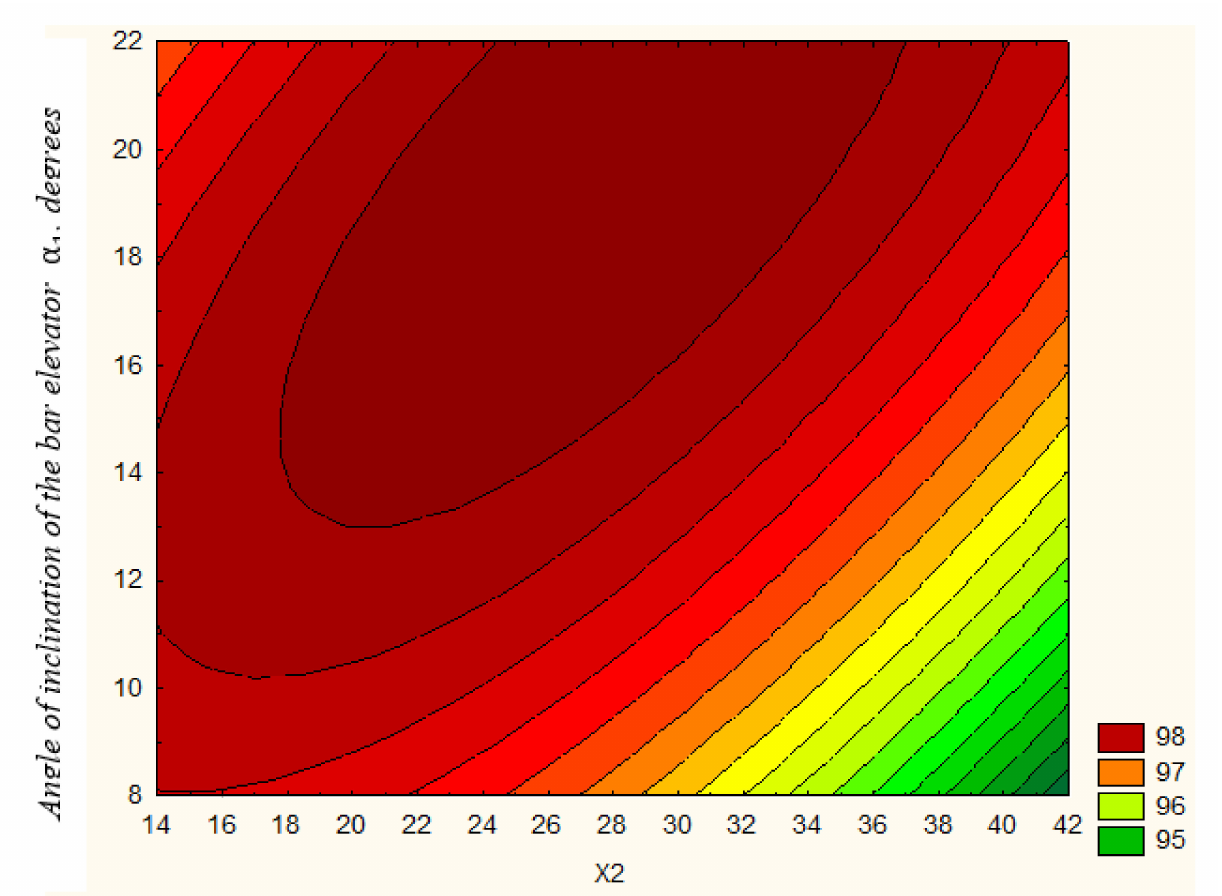
Figure 13. Two-dimensional cross-section of the response surface, characterizing the dependence of the completeness of the separation of the pile of onions on the supply of the pile of onions (kg/s) and the angle of inclination of the web of the rod elevator